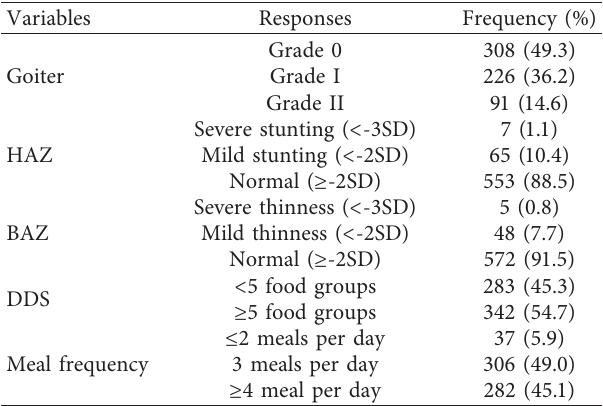
Table 1: Sociodemographic characteristics of participants in the North Shewa Zone,